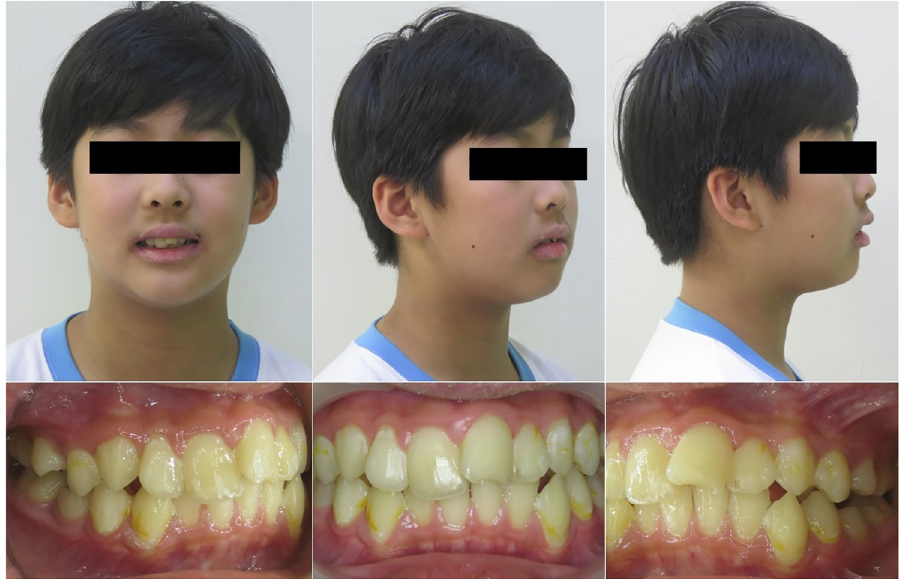
Fig 1. A 13-year-oldboy with a history of allergic rhinitis (AR) suffered dental trauma injury at the left maxillary incisor due to sport accident. The profile shows lip incompetence , a weak lip , and an acute nasal labial angle . The oral finding was Angle class II malocclusion with a large overjet and proclinating incisors . Consent to publication was obtainedform the parents of the patient (S1 File.)